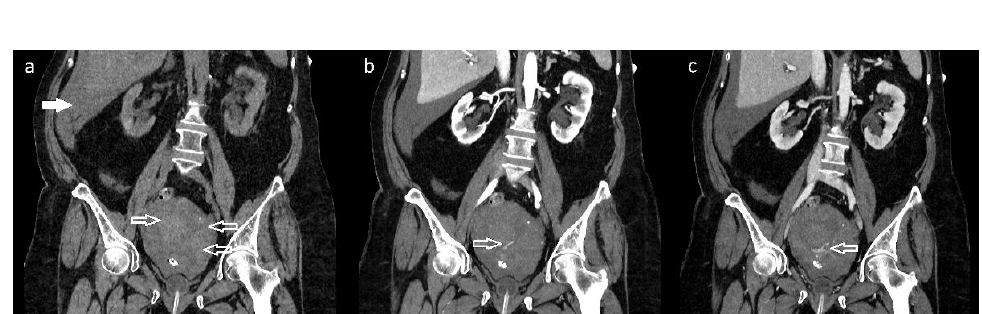
Figure 1. Abdominal computed tomography (CT) scan with the application of 90 mL intravenous contrast medium Visipaque 320 revealed a uterine tumor involving the cervix (size: 40 × 50 × 70 mm), hematometra with active bleeding from the tumorous mass, and a hemoperitoneum. ( a ) Non-contrast: coronal plane with hematometra in the enlarged uterus with tumor (arrows) and hemoperitoneum located in the Morison’s pouch (full arrow). ( b ) Contrast enhanced: coronal plane (arterial phase 30 s after applying the contrast agent) where an active extravasation of the contrast agent from the dorsocaudal part of the tumor can be seen (arrow). ( c ) Contrast enhanced: coronal plane (venous phase 70 s after applying the contrast agent). Continued process of the extravasation of the contrast agent, pointing to actively bleeding arterial area (arrow). A 67-year-old patient was referred to our department with a sudden onset of sharp lower abdominal pain and an episode of vaginal bleeding. The patient had a short history of intermittent, low-intensity postmenopausal bleeding and the diagnosis of pelvic mass on the ultrasound (although the diagnostic process for this was incomplete). Upon admission the patient had tachypnea, tachycardia, and diffuse ab- dominal rigidity. A speculum vaginal examination showed a small and extremely hard to visualize portion of ectocervix and, by bimanual palpation, a tumorous mass (involving both cervix and par- ametria) was diagnosed (minimal vaginal bleeding present). An urgent computed tomography scan was ordered which revealed an enlarged uterus with a tumor in the cervical region and active ex- travasation in the arterial and venous phase after applying the contrast, which pointed to active arterial bleeding from the lesion causing hematometra and subsequently uterine rupture and hemoperitoneum. We considered an acute surgical intervention as an unfavorable option because it was a locally advanced disease which had altered the pelvic anatomy in an already hemodynam- ically unstable patient. There was also a significant drop in hemoglobin levels (123 g/L vs. 100 g/L samples taken in approximately 1.5 h interval), which pointed to a major blood loss. We were in- formed about the possibility of a UAE and, after the required initial management and blood trans- fusions, the patient was transported to the angiography department.